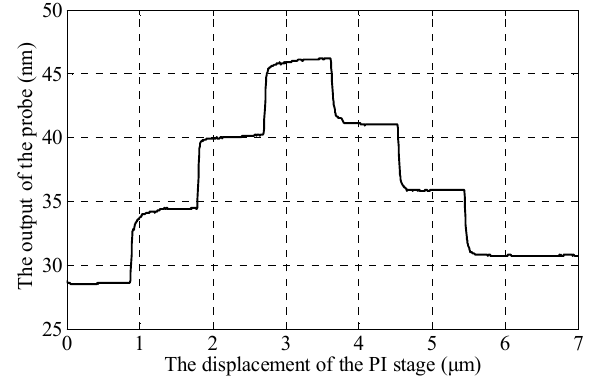
Figure 11. Resolution test results of the probe.